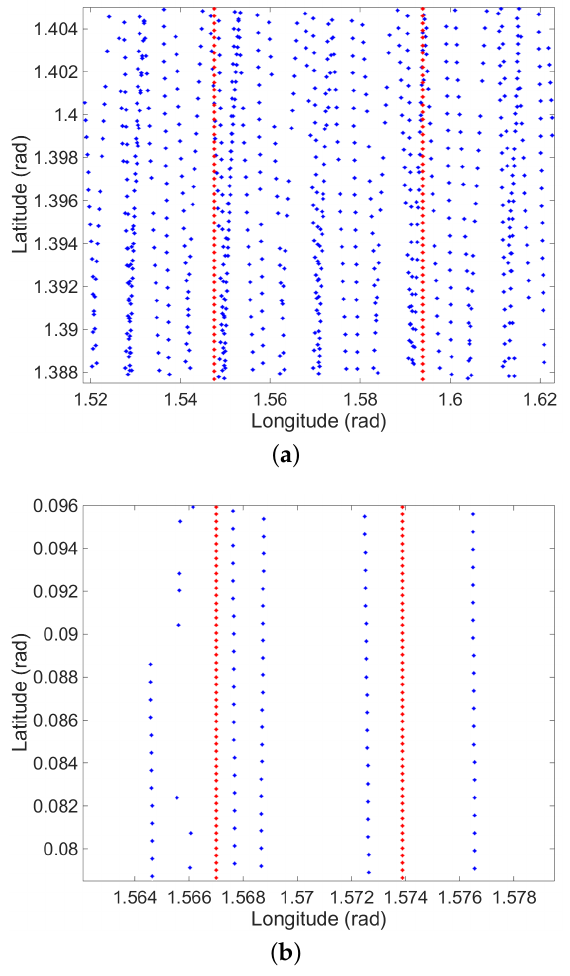
Figure 7. The distribution of simulated LAM data close to the pole ( a ) and Equator ( b ). The X and Y axes correspond to longitude and latitude, respectively. The blue dots indicate the simulated LAM data, and the red dots indicate the simulated GCPs for